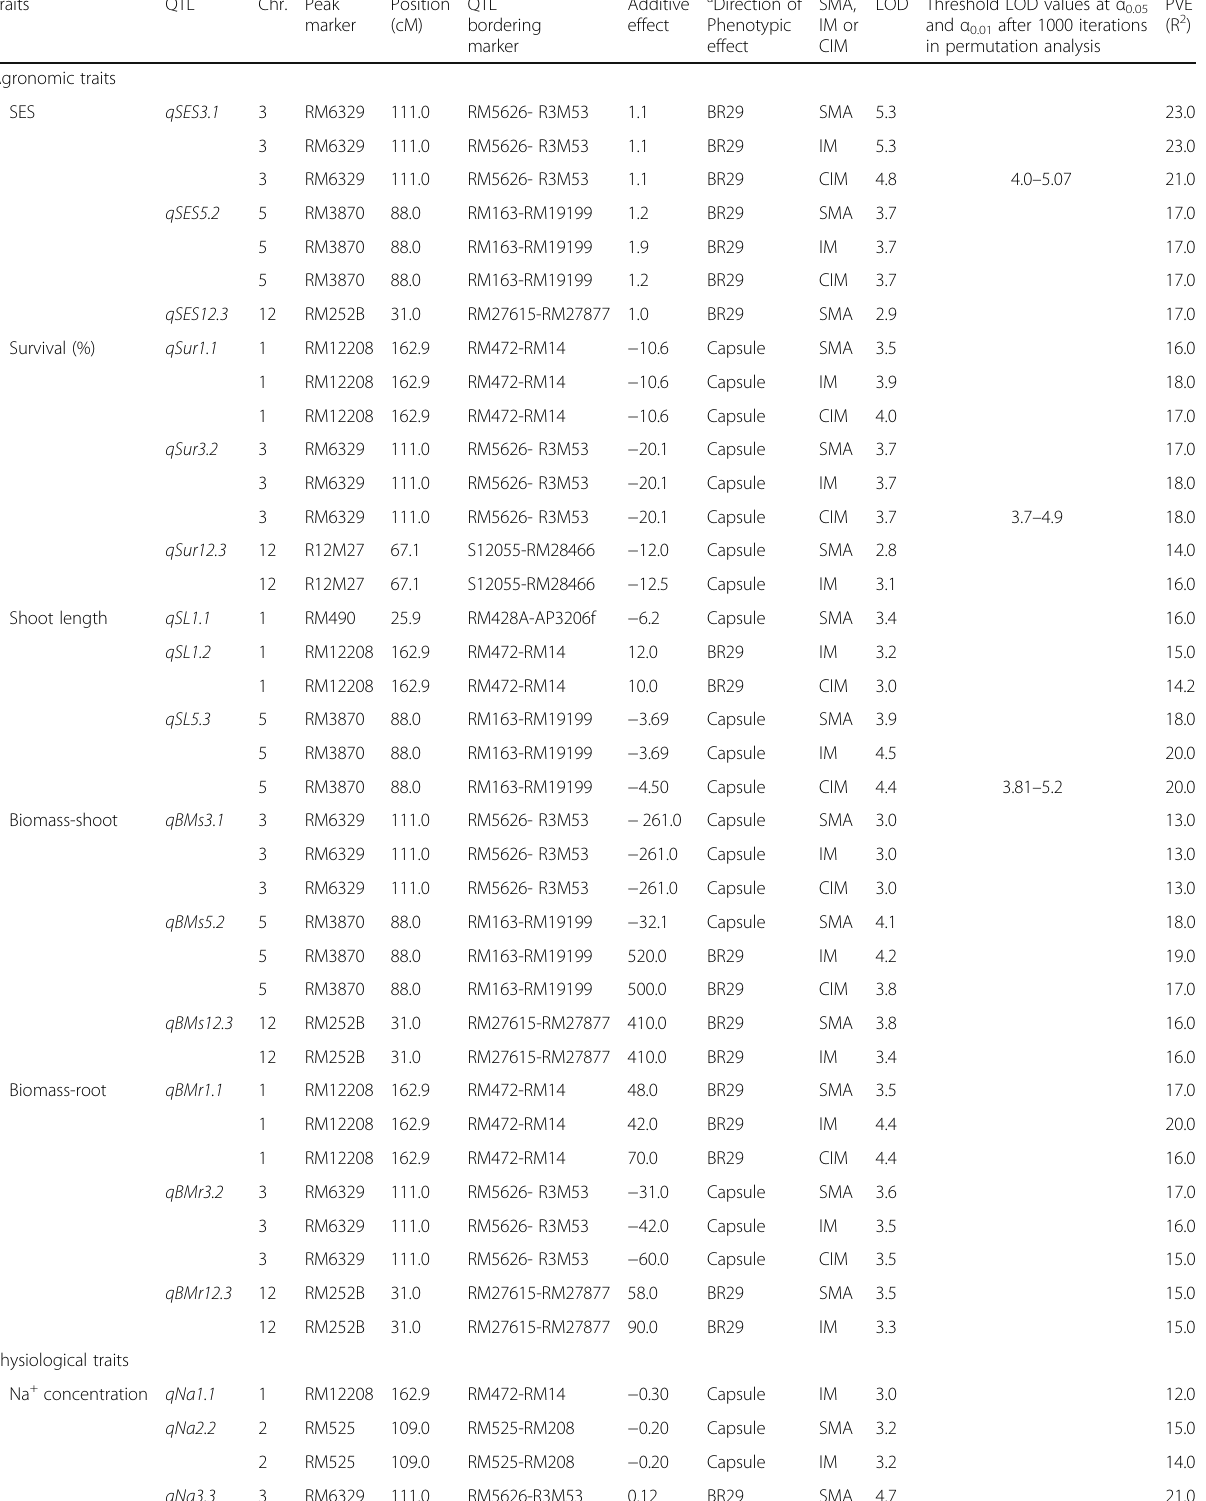
Table 3 QTL detected for salt tolerance-related traits viz. overall phenotypic performance (SES), survival, physiological and agronomic traits during seedling stage based on single-marker analysis (SMA), interval mapping (IM) and composite interval mapping (CIM) in the Capsule/BR29 F 2:3 population Traits QTL Chr. Peak marker Agronomic traits